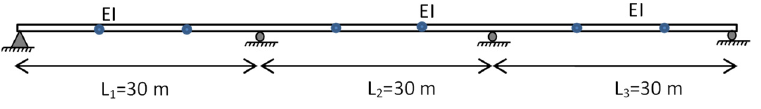
Figure 7. Three-span bridge model.